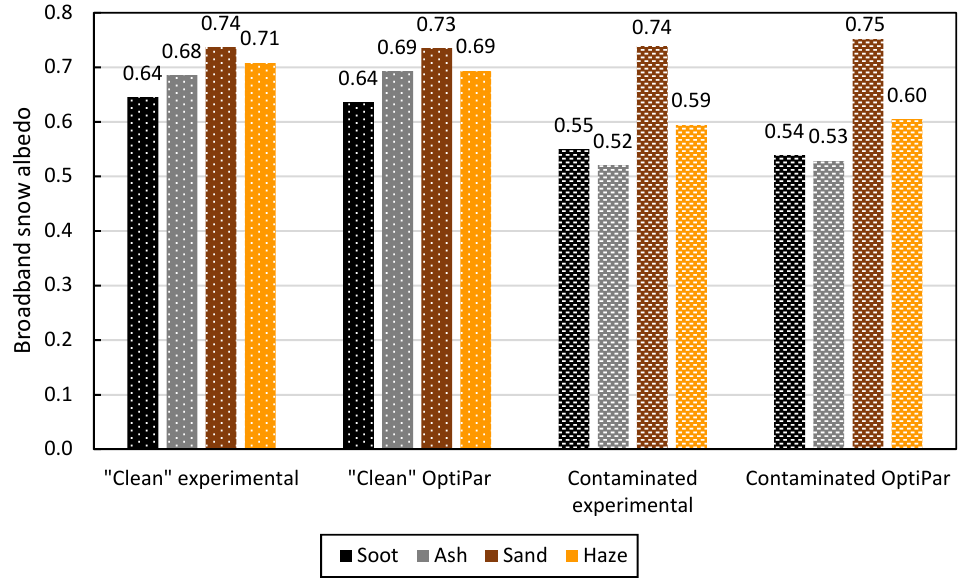
Figure 12. Broadband snow albedo of the experimental and modelled with OptiPar of “clean” and artificially contaminated snow surfaces with soot (black bar), ash (grey bar), sand (brown bar), and haze (orange bar).